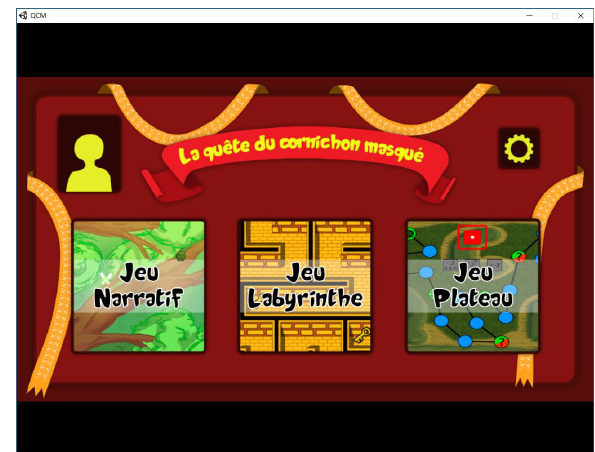
Figure 10. Experimented games in classroom: the main